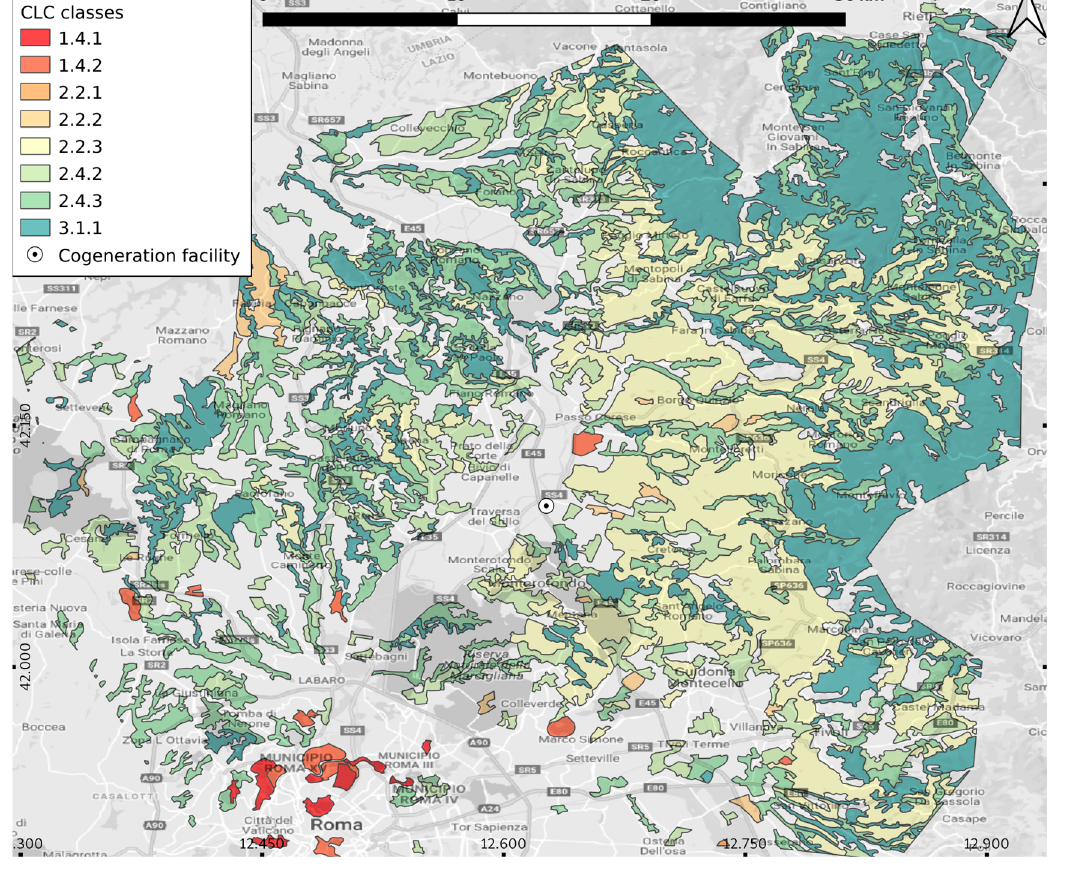
Figure 3. Spatial distribution of relevant land cover classes present in the study area.